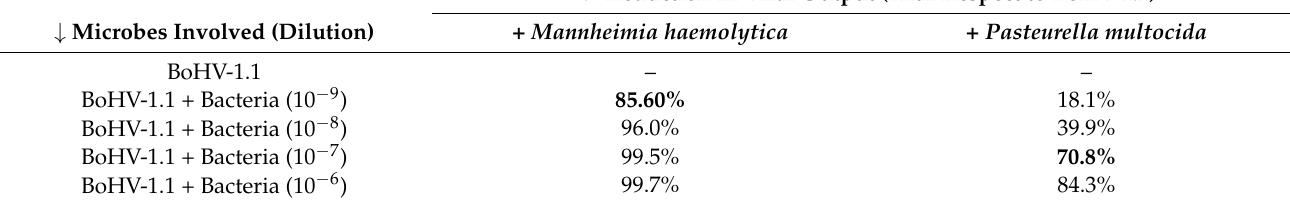
Table 1. Percent reduction in viral replication when in co-infection. Data used in Figure 1B is presented as a % reduction in viral replication with respect to the control sample (cells singly infected with BoHV-1.1). MDBK cells were infected with BoHV-1.1 only (MOI 1) or with BoHV-1.1 and M. haemolytica or P. multocida diluted as shown. Supernatants were assayed for viral infectius particles at 24 h. % reduction = 100 − (bacteria + virus pfu/mL counts)/(virus pfu/mL counts) × 100. Highlighted (bold) is the bacterial dilution at which the reduction was significant (see also Figure 1B). % Reduction in Viral Output (with Respect to